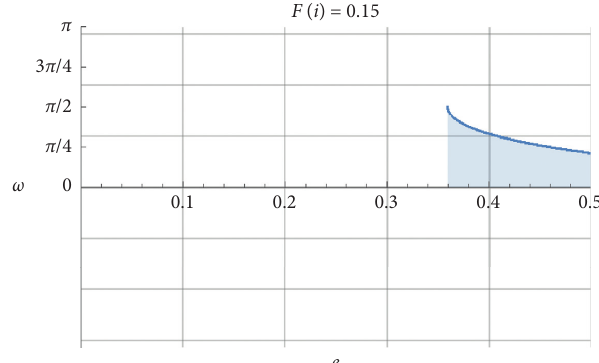
Figure 9: The curve ω ( e ) at which _ e � _ i � 0 for F ( i ) � 0.15.